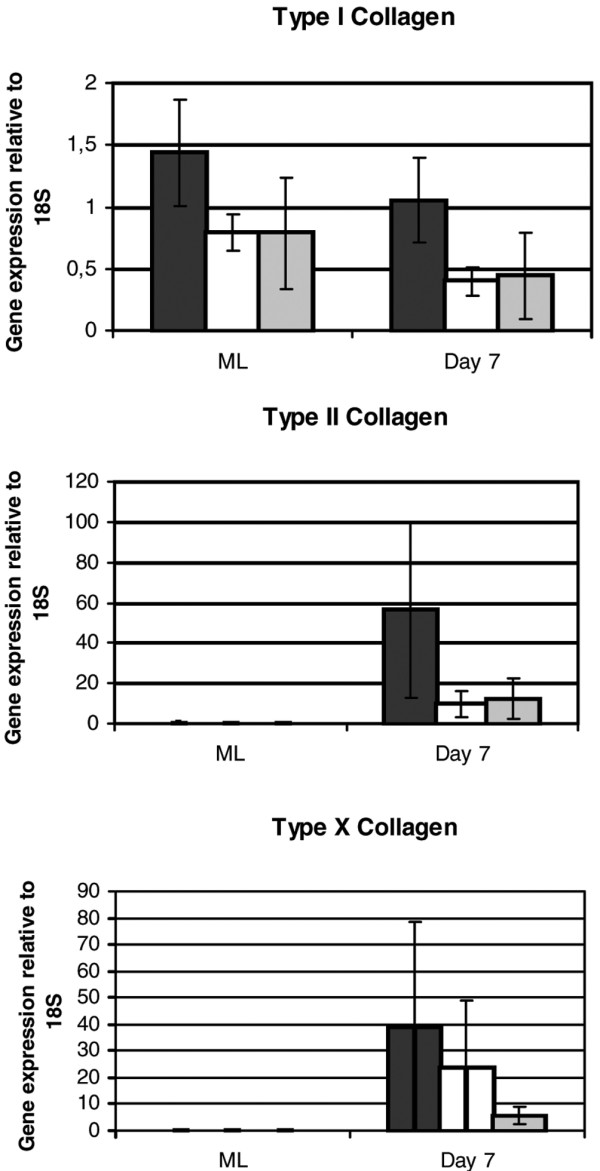
Gene expression of cells cultured in pellets. The graphs show the quantitative gene expression of typical cartilage gene expression markers (types I, II and X collagen) in the monolayer (ML) and in day 7 pellets. Results are means ± SD for separate donors (n = 4) from samples from autologous chondrocyte transplantation patients (black bars) and from affected (grey bars) and unaffected (white bars) areas.